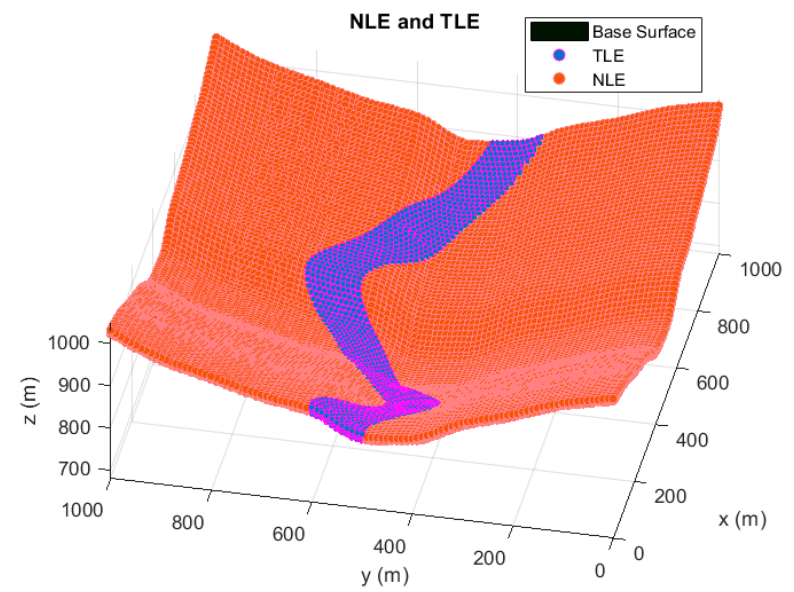
Figure 2. The scenario of simulations. The reference surface is depicted is grey tones. Node Location Environment (NLE) and Target Location Environment (TLE) regions are respectively shown in orange and purple colors. The discretized points of the TLE zone are the points employed for the optimization of the Time Difference of Arrival (TDOA) architecture performance. In the case of the NLE area, the points shown are only a representation of the area where every sensor can be located.